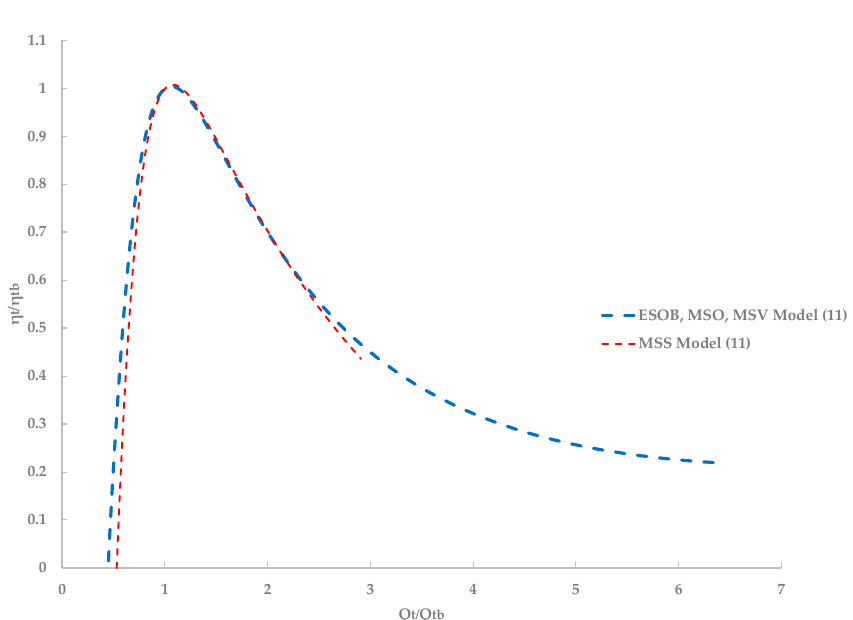
Figure 6. Comparison of efficiency curves evaluated using Relationship (11) for the ESOB, MSV, and MSO model with the MSS ones.